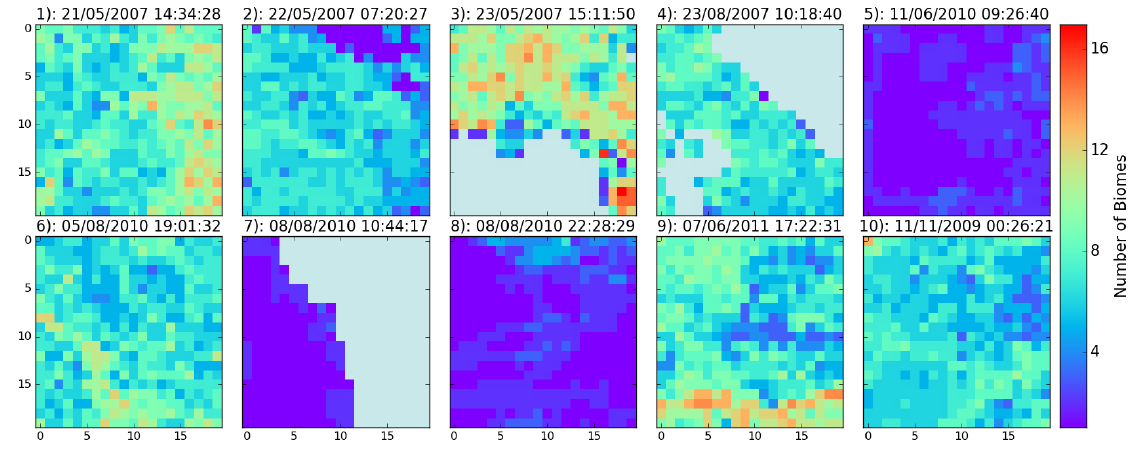
Figure 7. Number of land biomes for the 10 submission scenes in the cloud clearing inter-comparison (Table 1) at 625-km 2 resolution. Individual plot headings give the scene number, date and orbit start